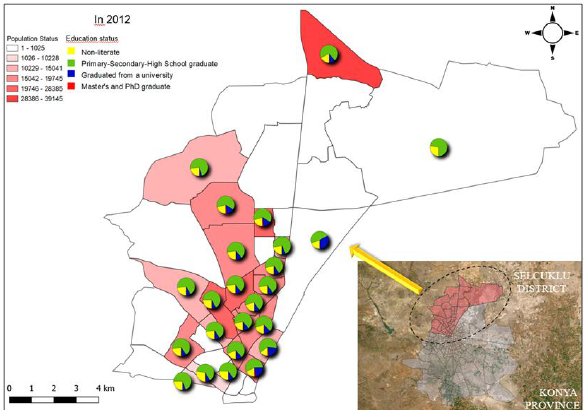
Figure 5. Spatial distribution of demographic data for 2012